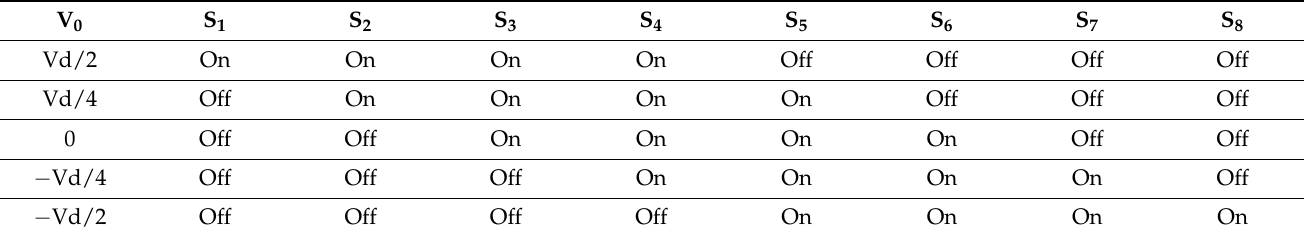
Figure 9. Cascaded H-bridge MLI with 8 switches. Table 4. Switching positions of cascaded H-bridge MLI .